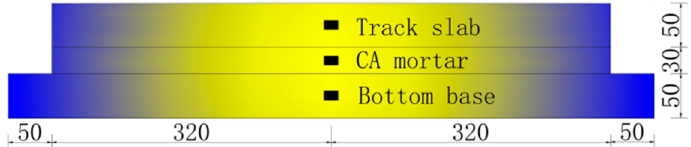
Figure 4. The layout of the fiber Bragg grating (FBG) strain sensors (Unit: mm).